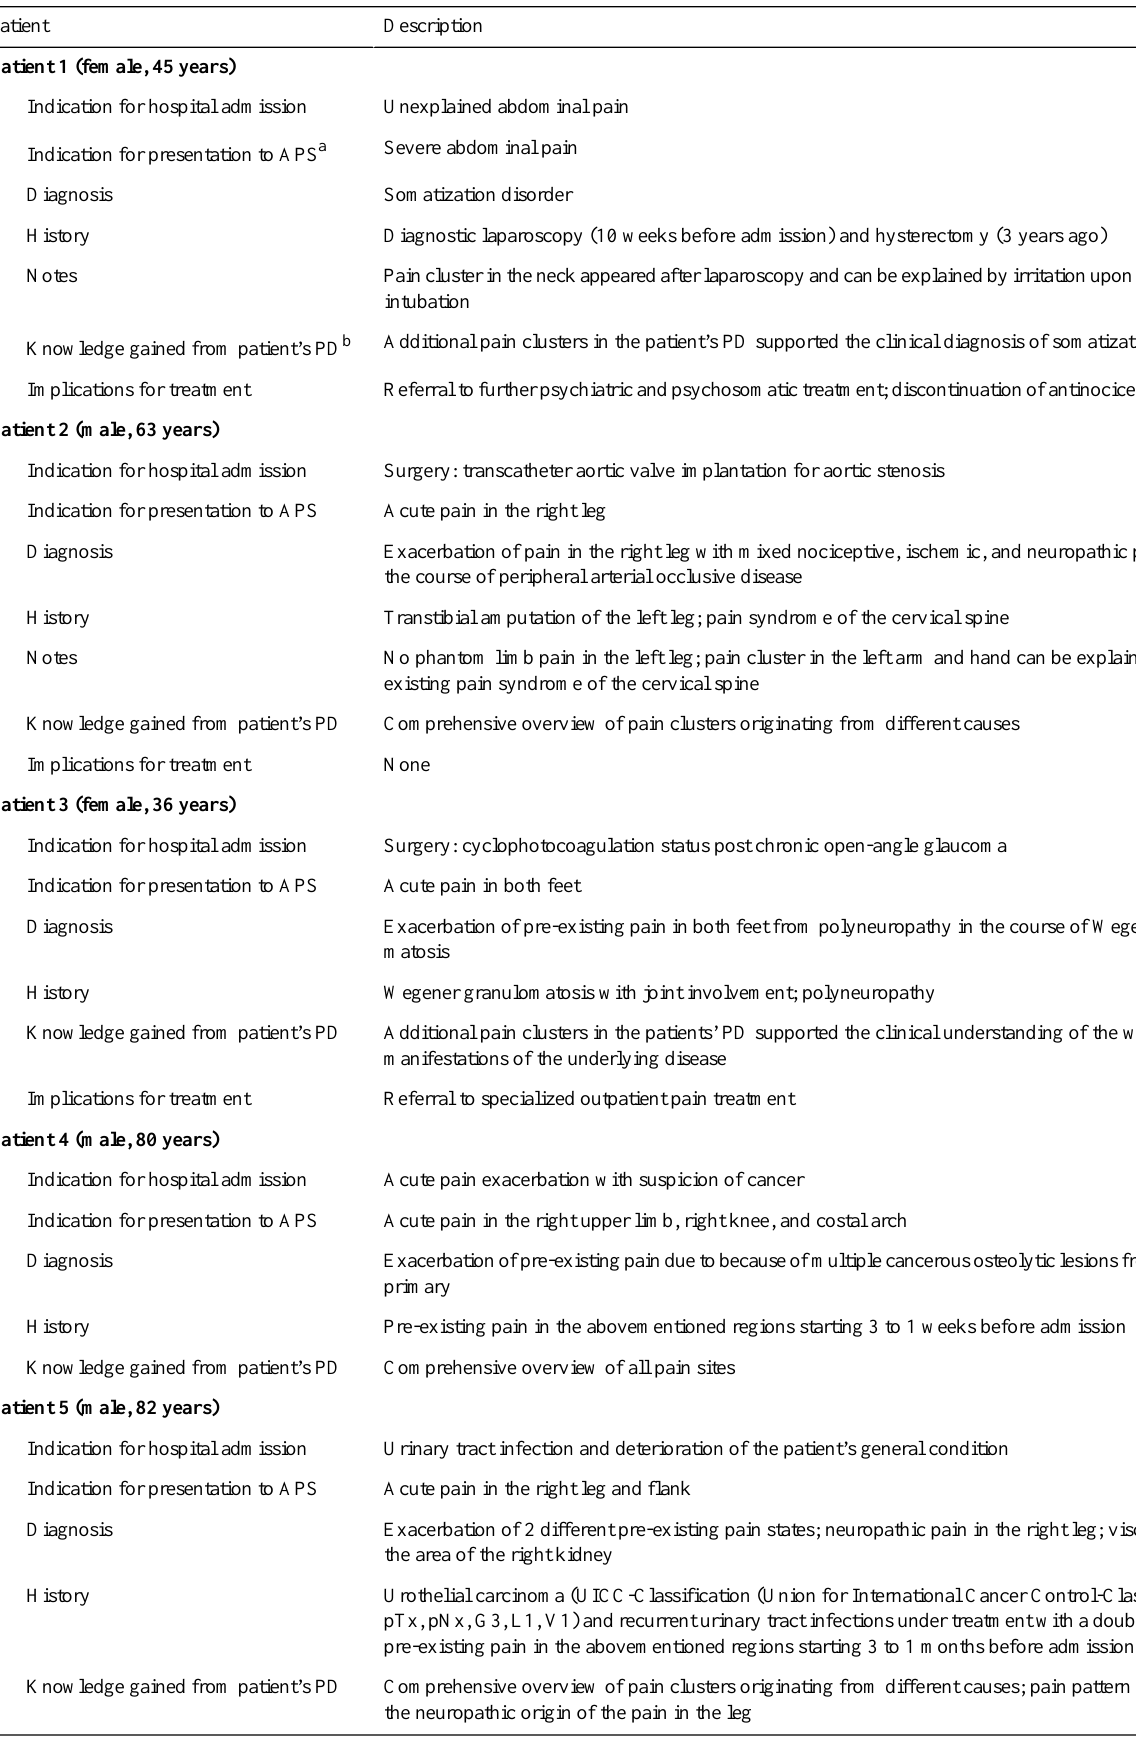
Table 5. Discussion of the patients in which knowledge of the PD led to strong improvement of the doctor’s understanding of